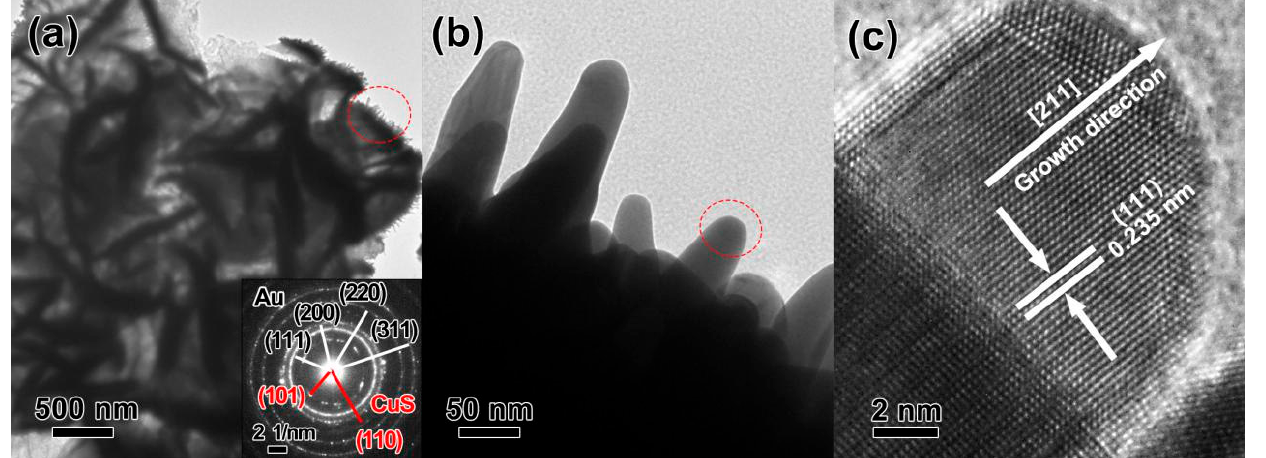
Figure 4. TEM and HR-TEM observations of 3D hierarchical Au/CuS MFs. ( a ) Low-magnified image, ( b ) enlarged observation, and ( c ) the HR-TEM images of an isolated nanotip. The inset in ( a ) is the corresponding SAED pattern of the circled region, and those ascribed to CuS phase are marked in red